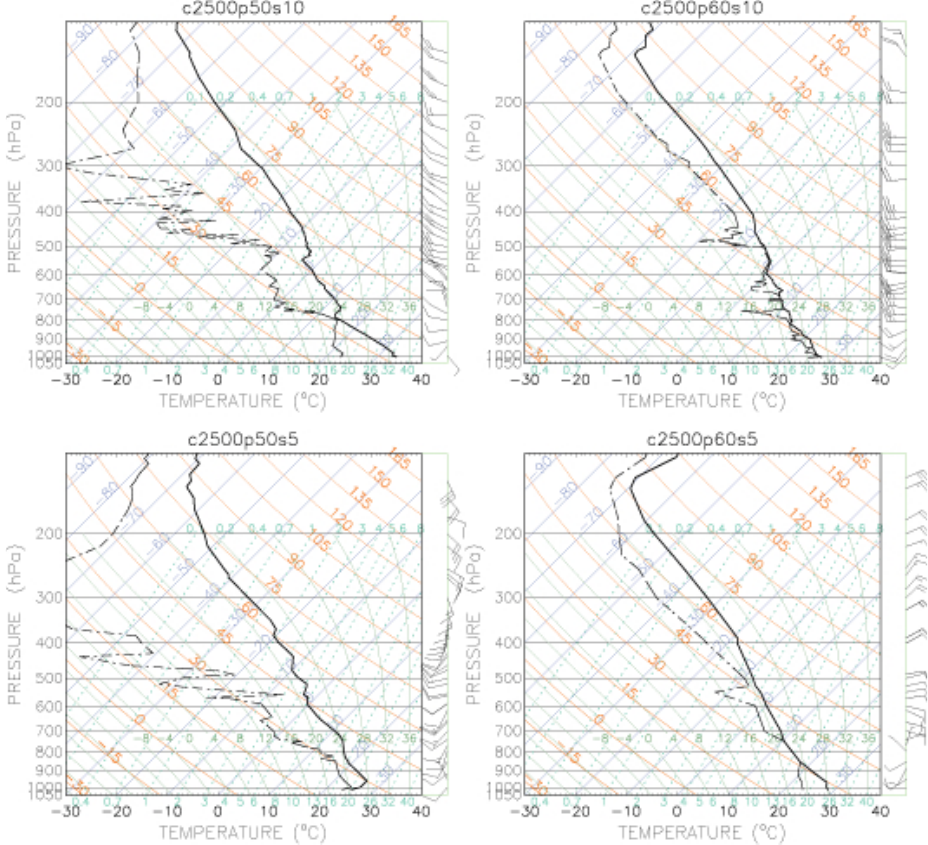
Fig. 5. Thermodynamic and wind profiles used to initialize numerical model simulations experiments c2500p50s10, c2500p60s10, c2500p50s5 and c2500p60s5 are shown in top left, top right, bottom left and bottom right panels respectively.